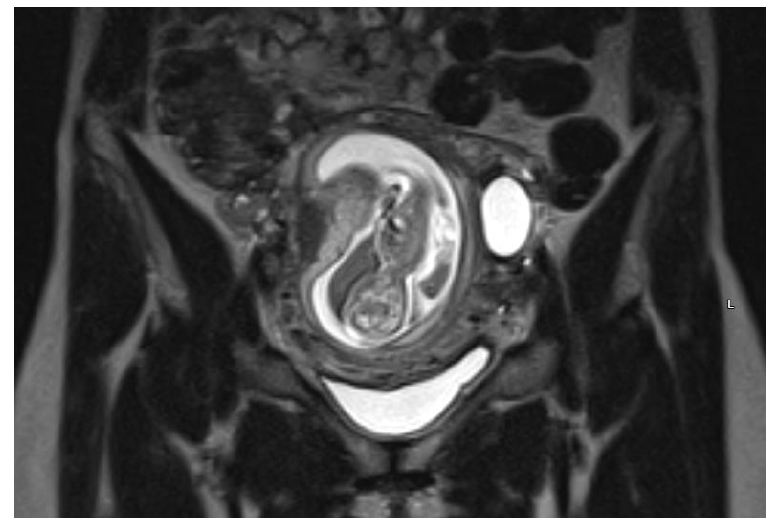
Figure 2. MRI scan of the uterus on the 13w + 3d.